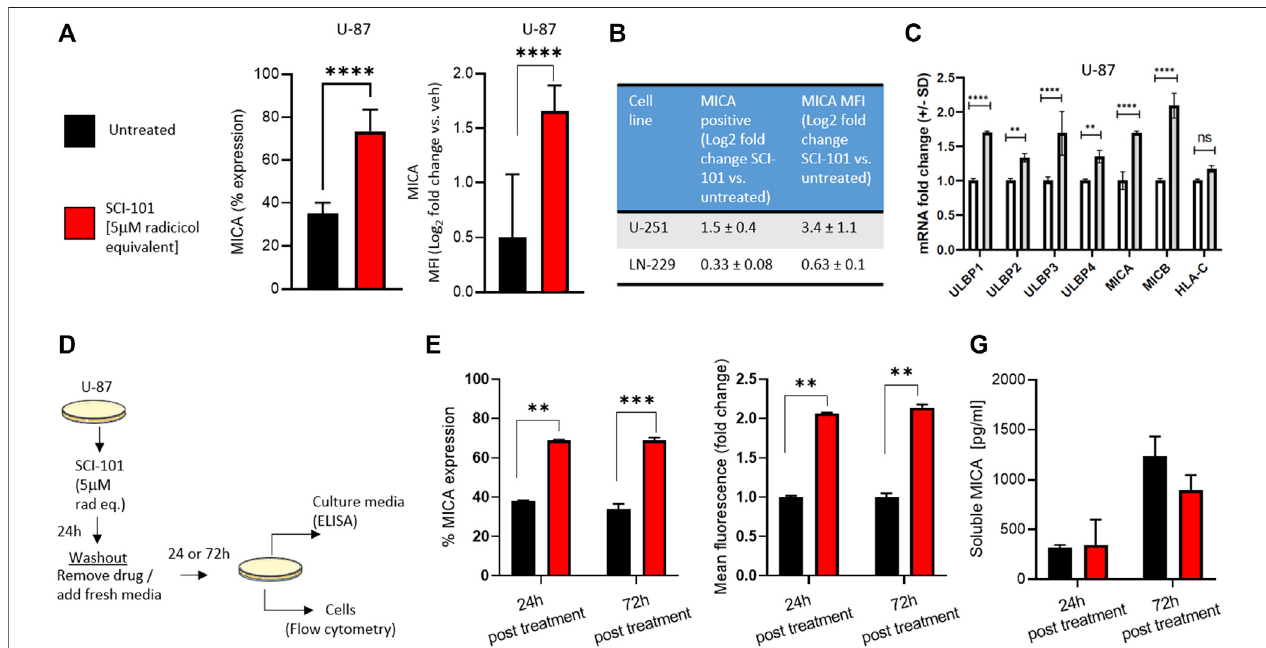
FIGURE3| FunctionalcharacterizationandimmunogeniceffectsofSCI-101onGBMcells. (A) FlowcytometricanalysisofMICAexpression andmean fl uorescent intensity (MFI) in U-87 GBM cells exposed to SCI-101 for 72 h (5 μ M). ****p < 0.0001 by Student ’ s t-test. N > 4 in biological replicate. (B) Table quantifying MICA protein expression and MFI in U-251 and LN-229 GBM cells exposed to SCI-101 for 72 h. Values shown are the log 2 fold change between treated and untreated conditions. N > 3 in biological replicate of each cell line. (C) Graphs quantifying mRNA expression for the indicated genes as determined by quantitative PCR. Data are normalized to the GAPDH housekeeping gene. ****p < 0.0001, **p < 0.01, ns (cid:2) not signi fi cant. (D) Schematic illustration of the drug washout experimental design. U-87 cells were untreated or exposed to 5 μ M of SCI-101 for 24 h followed by drug washout and replaced with clean media. 24 and 72 h after treatment, the cells were analyzed by fl ow cytometry or ELISA as described in panels (E, F) . (E) Flow cytometric analysis of MICA expression and MFI in U-87 GBM cells exposed to SCI-101 for 72 h (5 μ M) following the schematic in panel (D) . ** p < 0.01, *** p < 0.001 by Student ’ s t-test. N (cid:2) 4 in biological replicate. (F) Soluble MICA was determined in U-87 cell culture media following the schematic in panel (D)